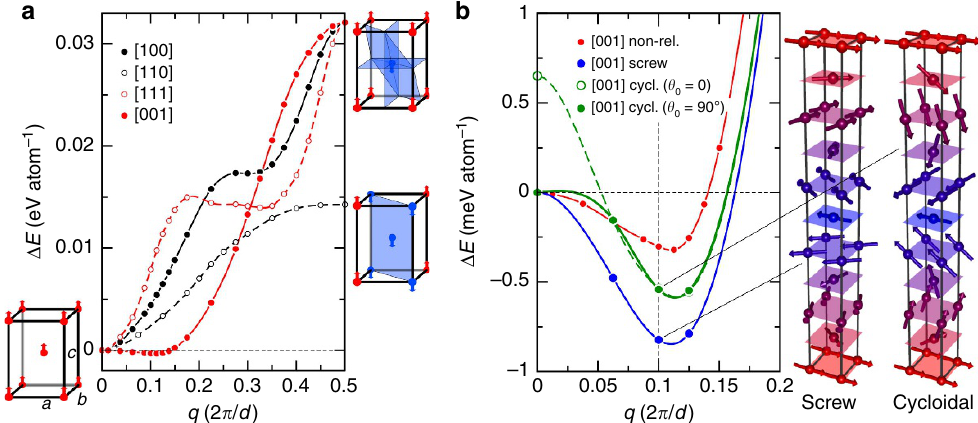
Figure 4 | Theoretical calculations on Pt 2 MnGa. Total energies D E calculated as functions of q (in units of 2 p / d , where d is the distance between the p nearest Mn-containing planes orthogonal to q ). ( a ) Non-relativistic regime: black solid and dashed lines refer to [100] ( d ¼ a /2) and [110] ( d ¼ a = ffiffiffi 2 ) q ffiffiffiffiffiffiffiffiffiffiffiffiffiffiffiffiffiffiffiffiffiffi directions, respectively; red dashed and solid lines—to [111] ð d ¼ ð c = 2 Þ = 2 ð c = a Þ 2 þ 1 Þ and [001] ( d ¼ c /2) directions, respectively. The energy zero is taken at q ¼ 0 (ferromagnet). ( b ) Detailed comparison of different regimes along [001]: red, blue and green lines/points refer to the non-relativistic (same as [001] in ( a )), screw- and cycloidal-type spirals, respectively. Cycloidal order has two variants: the first one (dashed green line, open circles) at q ¼ 0 represents a hard- c -axis oriented ferromagnetic state ( y 0 ¼ 0) and the second one (solid green line, filled circles) at q ¼ 0 represents an easy- ab -plane oriented ferromagnetic state ( y 0 ¼ 90 (cid:2) ). The energy zero corresponds to the easy- ab -plane ferromagnetic order. All lines are given for an eye guide. For several specific configurations, the Mn(2 a ) magnetic sublattice is shown explicitly; spin moments are coloured from red to blue according to their phase.